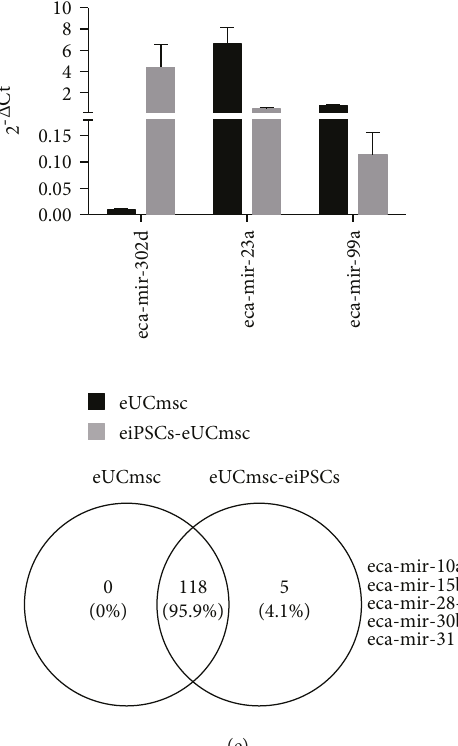
Figure 4: (a) PCA analysis of all 110 miRNAs commonly detected in eiPSCs derived from adipose tissue mesenchymal cells, umbilical cord tissue mesenchymal cells, fi broblasts, and control cells from each of these groups, suggesting slight clustering and di ff erence between the nonreprogrammed and reprogrammed cells. The more clustered and segregated the groups and points, the greater the similarities among the groups. (b) Venn diagram showing distribution of the miRNAs analyzed on the three cell groups and the presence of the 110 miRNAs commonly detected in all of them. (c) Expression levels of miRNA di ff erently expressed between eiPSCs-eADmsc and eADmsc cells ( P < 0 05 ) and Venn diagram of miRNAs exclusively expressed in eADmsc and eiPSCs-eADmsc. (d) Expression levels of miRNAs di ff erently expressed between eiPSCs-eFibros and eFibros cells ( P < 0 05 ) and Venn diagram of miRNAs exclusively expressed in eFibros and eiPSCs-eFibros. (e) Expression levels of miRNAs di ff erently expressed between eiPSCs-eUCmsc and eUCmsc cells ( P < 0 05 ) and Venn diagram of miRNAs exclusively expressed in eUCmsc and